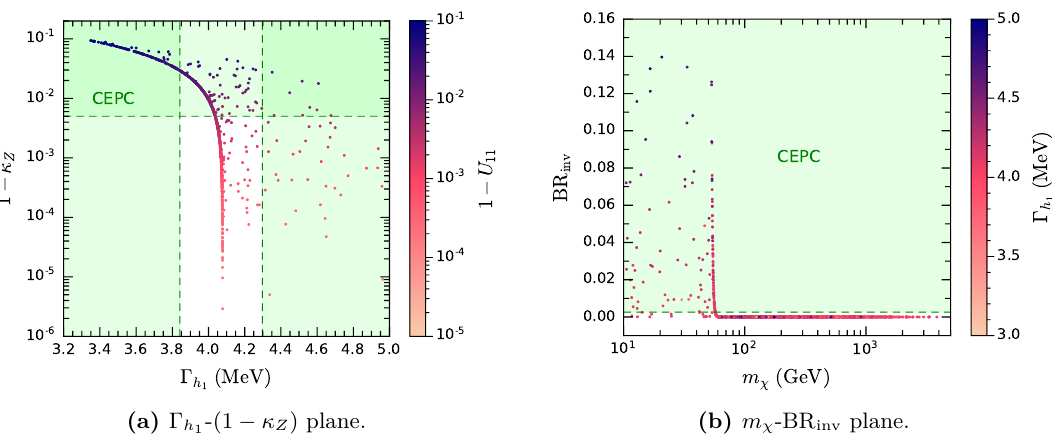
- (1 − κ ) (a) and m - BR (b) planes, Z χ inv 1 and Γ , respectively. The green regions denote the 11 h 1